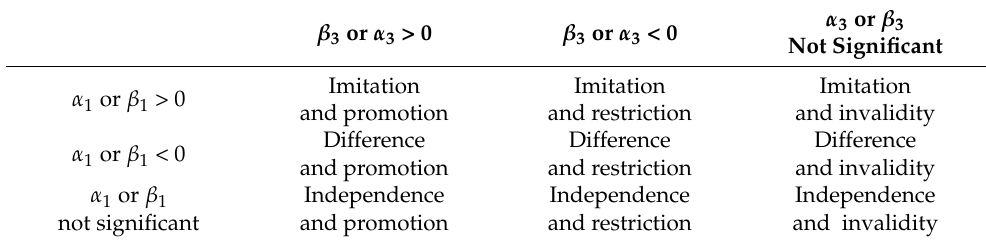
Table 1. The functional form of ER and LP.